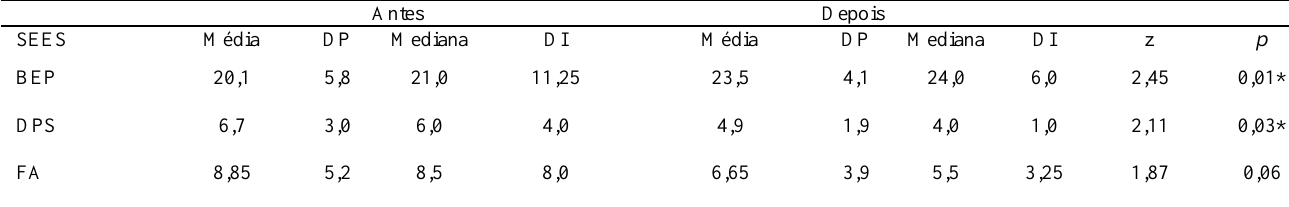
Tabela 3. Média, desvio-padrão, mediana, desvio interquartílico e resultados do teste Wilcoxon para cada subescala da SEES referentes ao exercício realizado em AV (n=20).